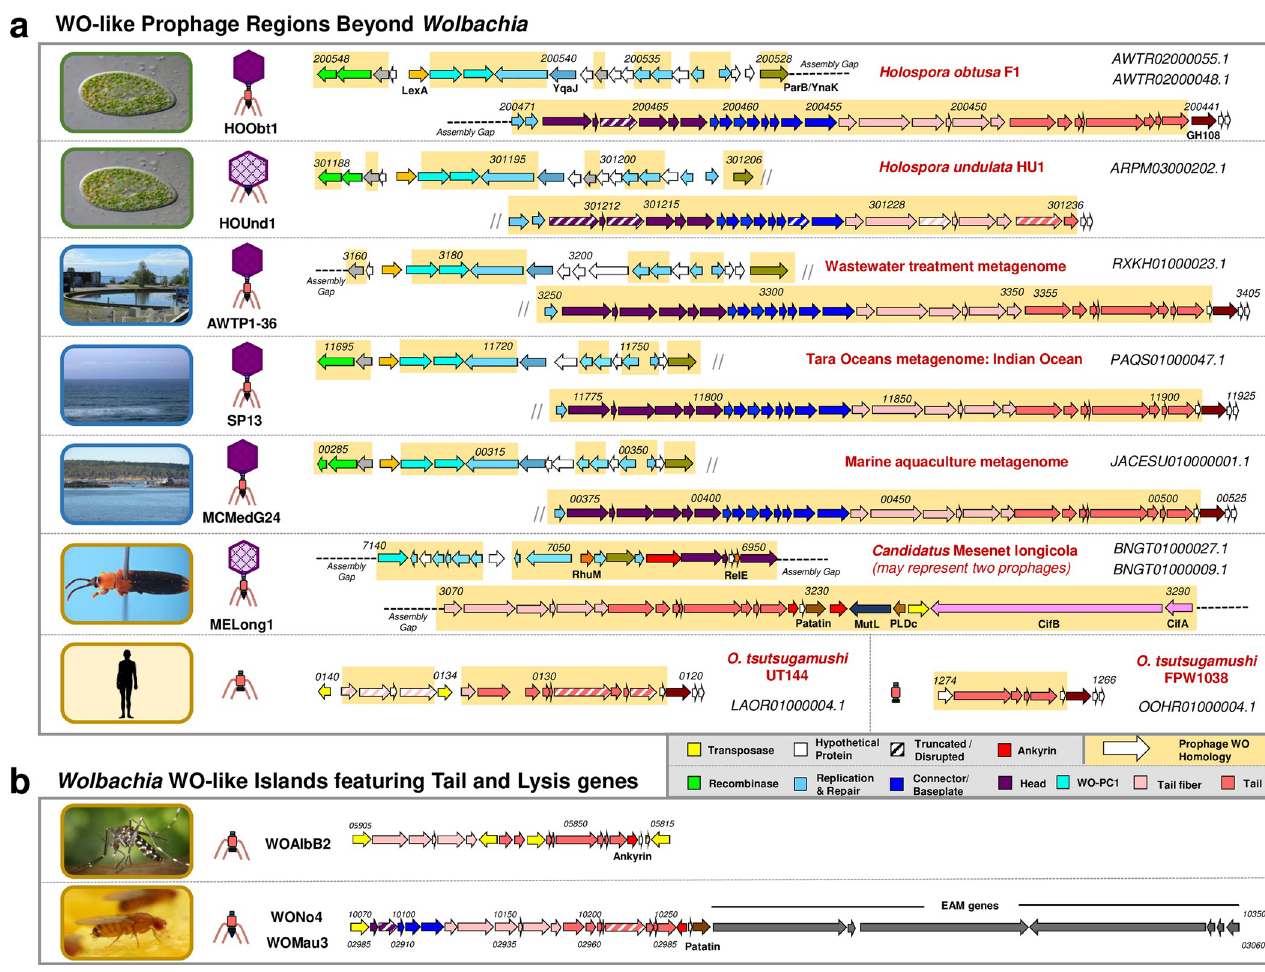
Fig 6. WO-like prophage regions are found in endonuclear Paramecium endosymbionts, aquatic environments, and other animal-associated bacteria. (a) Genome maps of non- Wolbachia prophage regions illustrate similar gene content and synteny to prophage WO. Locus tags are listed in italics above the genes; NCBI contig accession numbers are shown in the right-hand corner of each genome. Dashed lines represent breaks in the assembly whereas small diagonal lines represent a continuation of the genome onto the next line. Genes with nucleotide homology to prophage WO are highlighted in yellow and genes of similar function are similarly color-coded according to the figure legend. Candidatus Mesenet longicola is the only genome to feature EAM genes, including cifA and cifB . Arrows with diagonal stripes represent genes that may be pseudogenized relative to homologs in other prophage genomes. Genome maps for H . elegans and H . curviuscula prophages are not shown. (b) WO-like Islands featuring tail and lysis genes share homology with the Orientia regions and may represent phage-derived bacteriocins. Predicted physical structures are illustrated to the left of each genome. Images illustrate the isolation source for each prophage: green borders represent protozoa; blue borders represent aquatic environments; gold borders represent animals. All images are available under creative commons or public domain; attribution information is provided in S8 Table.